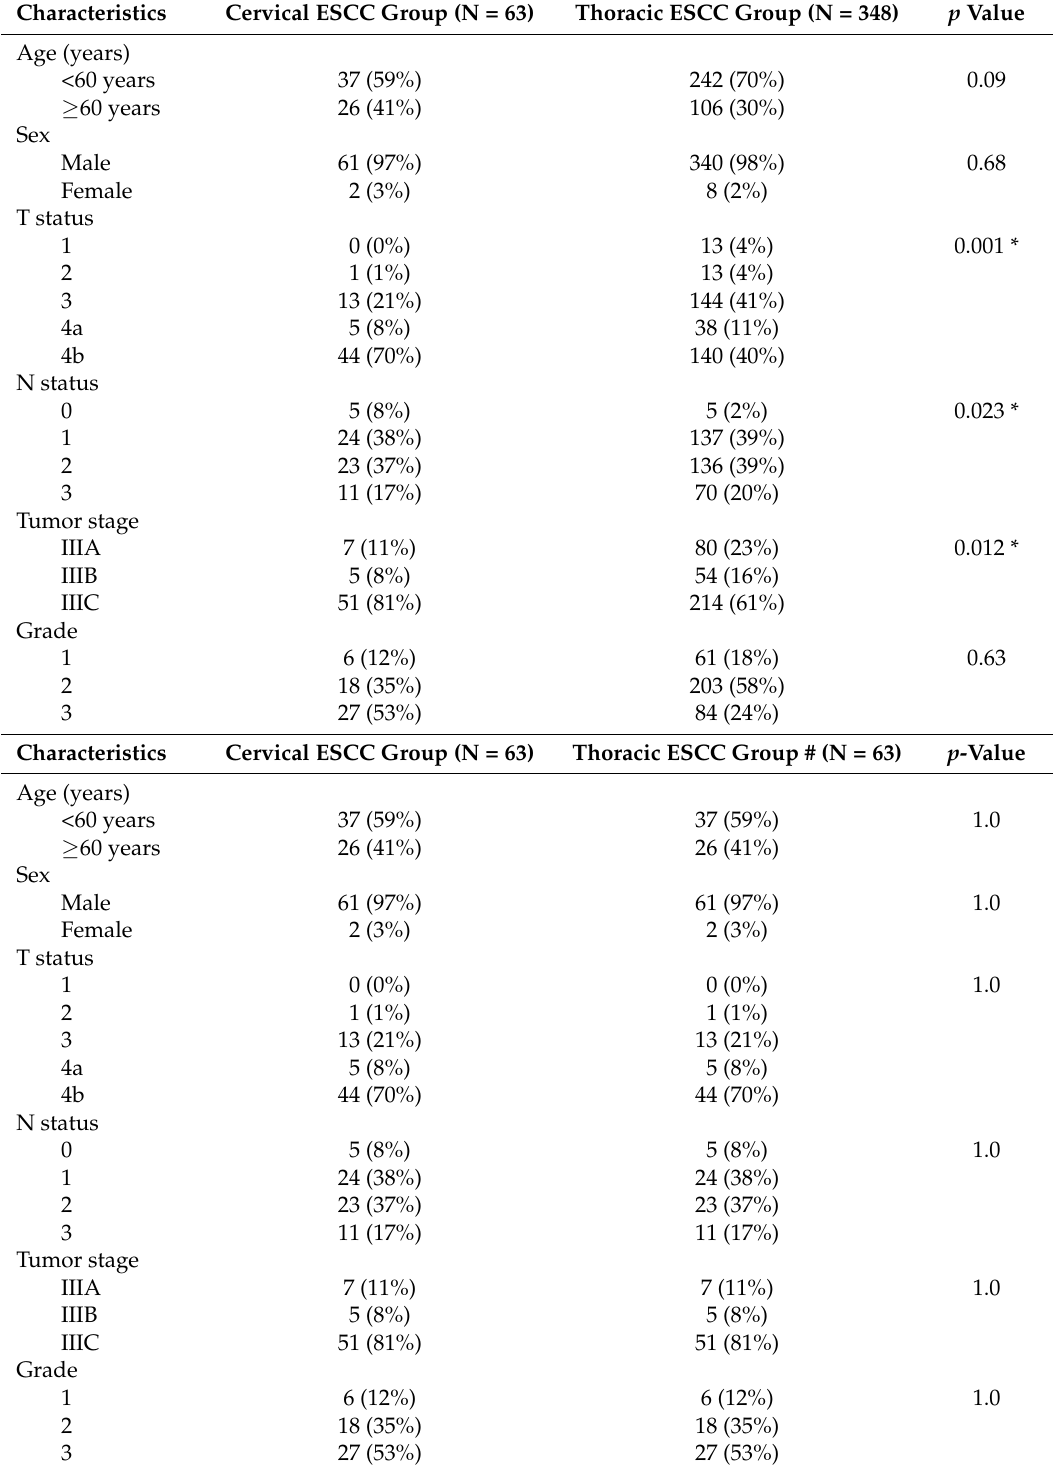
Table 1. The characteristics in 411 patients with locally advanced stage III cervical and thoracic esophageal squamous cell carcinoma who received curative concurrent